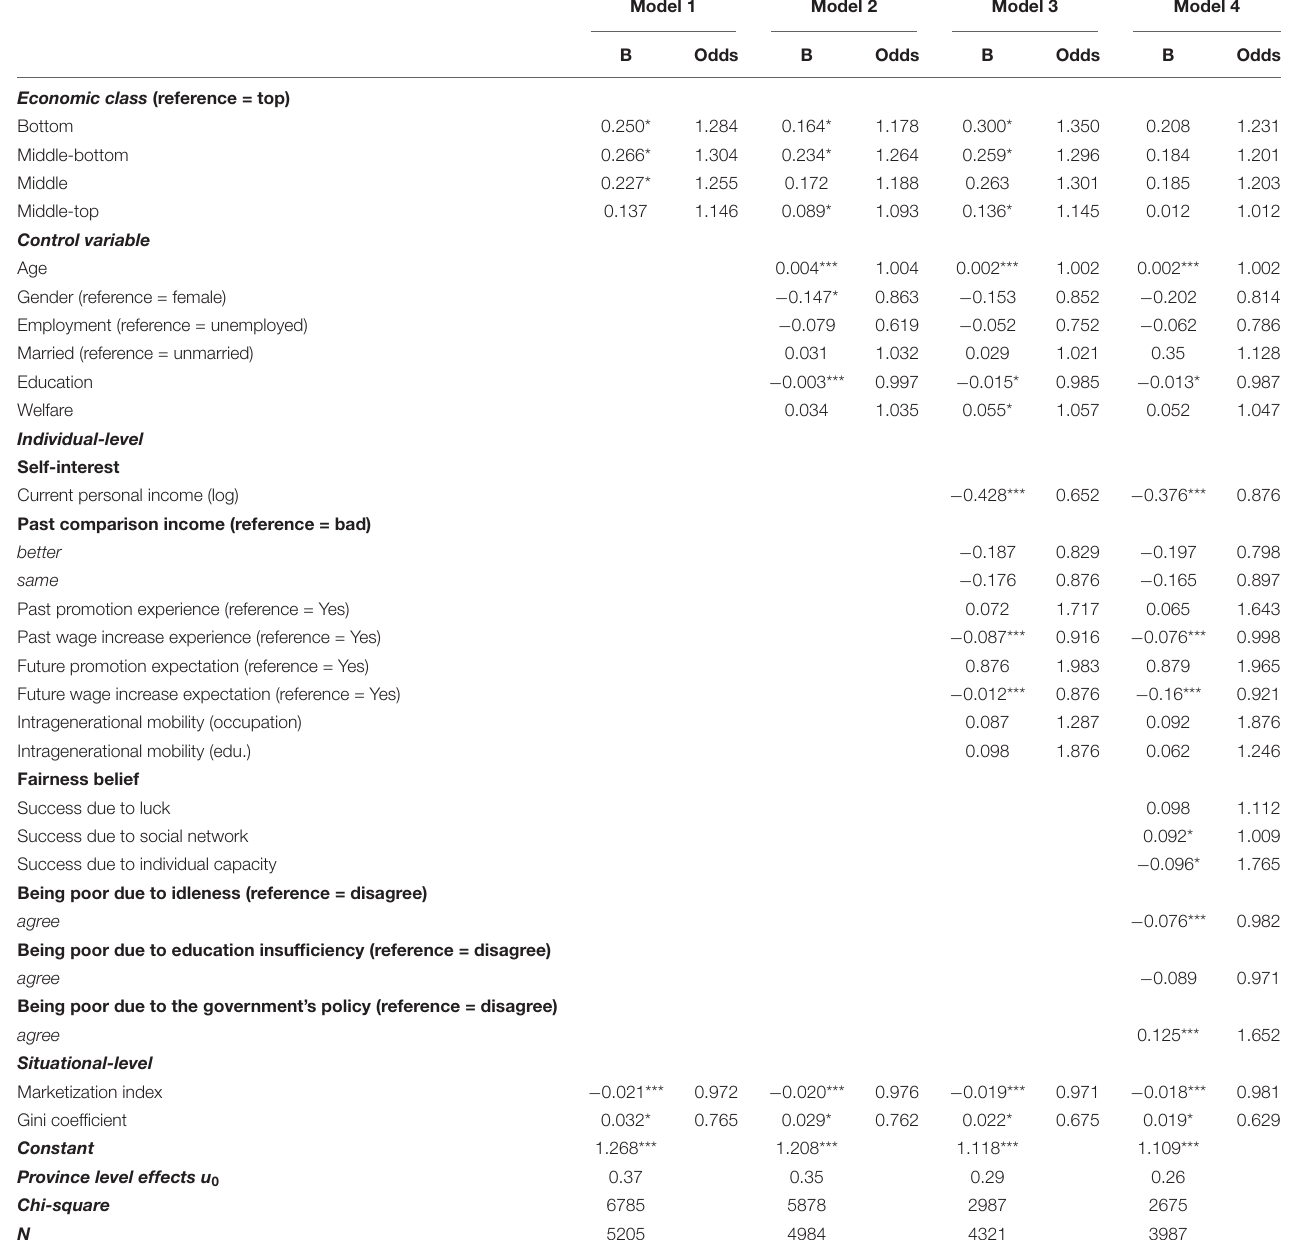
TABLE 3 | Hierarchical logistic regressions coefficient predicting odds of supporting establishing unemployment subsidy on individual-level and situational-level variables in